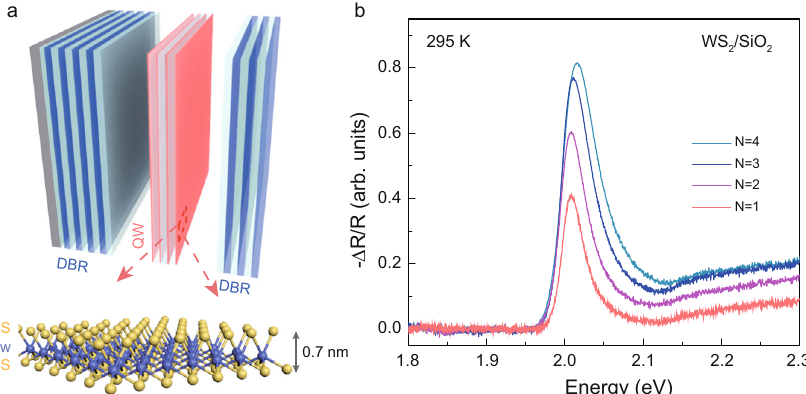
Fig.1|SchematicofthemultipleMLsmicrocavityandopticalcharacterization of the bare heterostructure. a Schematic image of the full dielectric microcavity structureembeddingmultipleWS 2 -MLs. b Re fl ectancecontrast( − Δ R / R )ofthebare